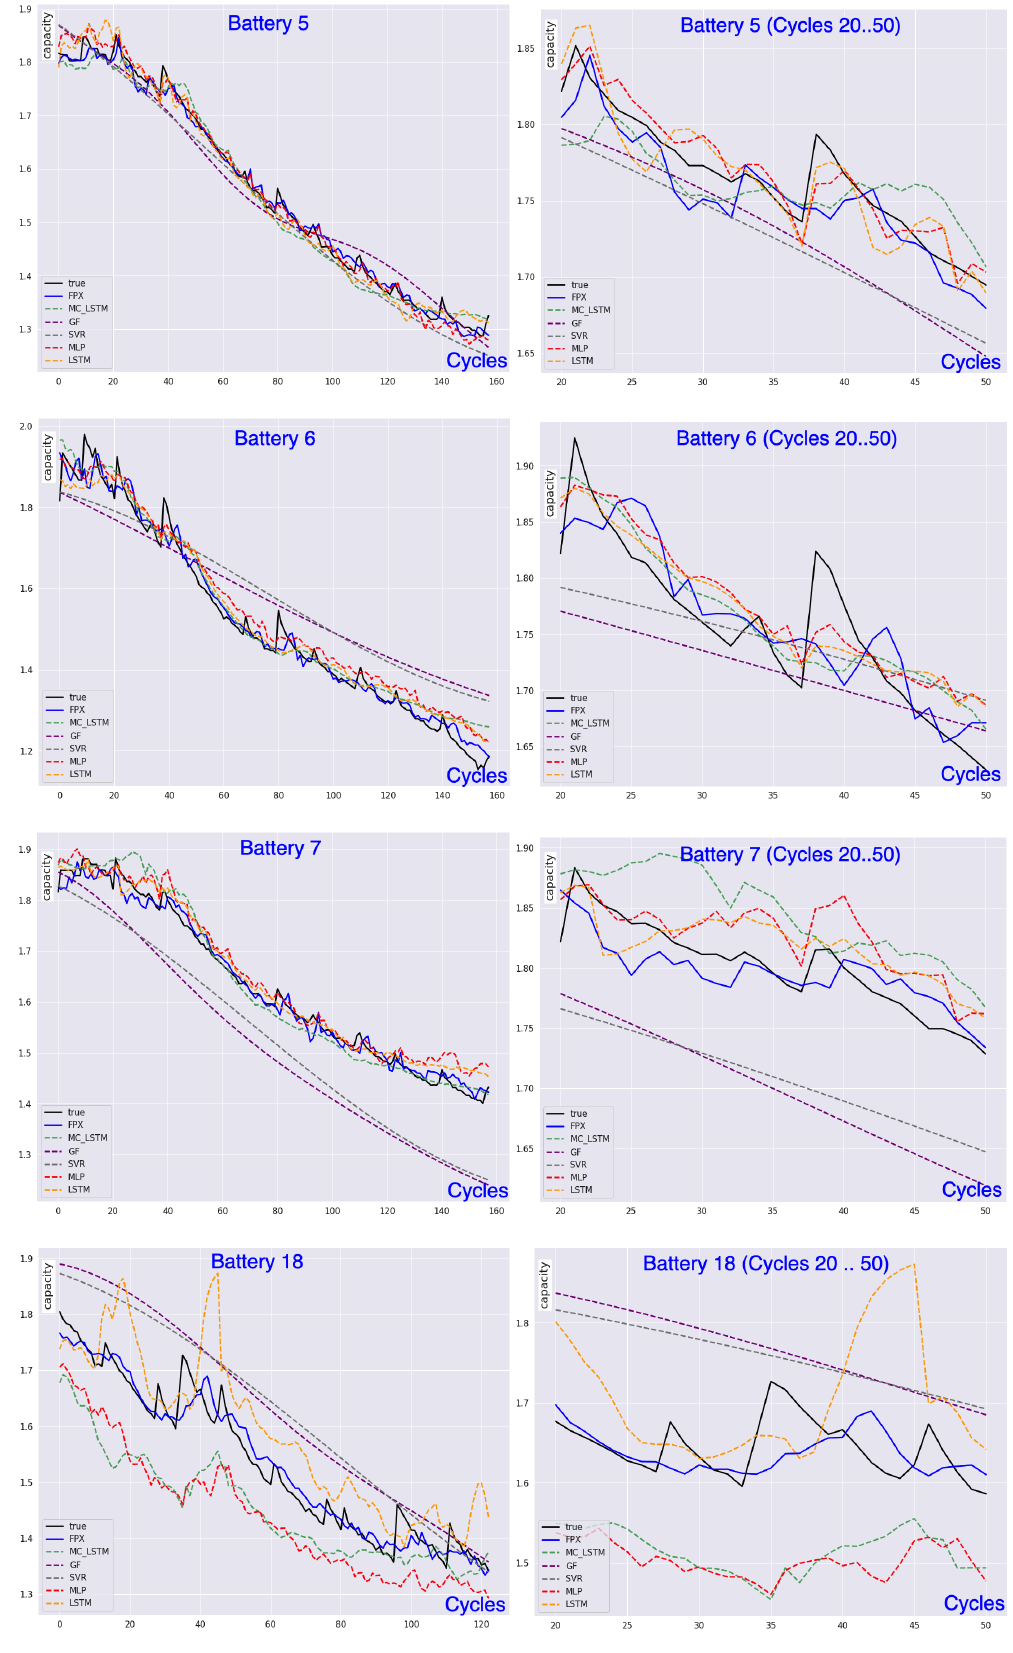
Figure 12. Accuracy comparison with different methods using NASA